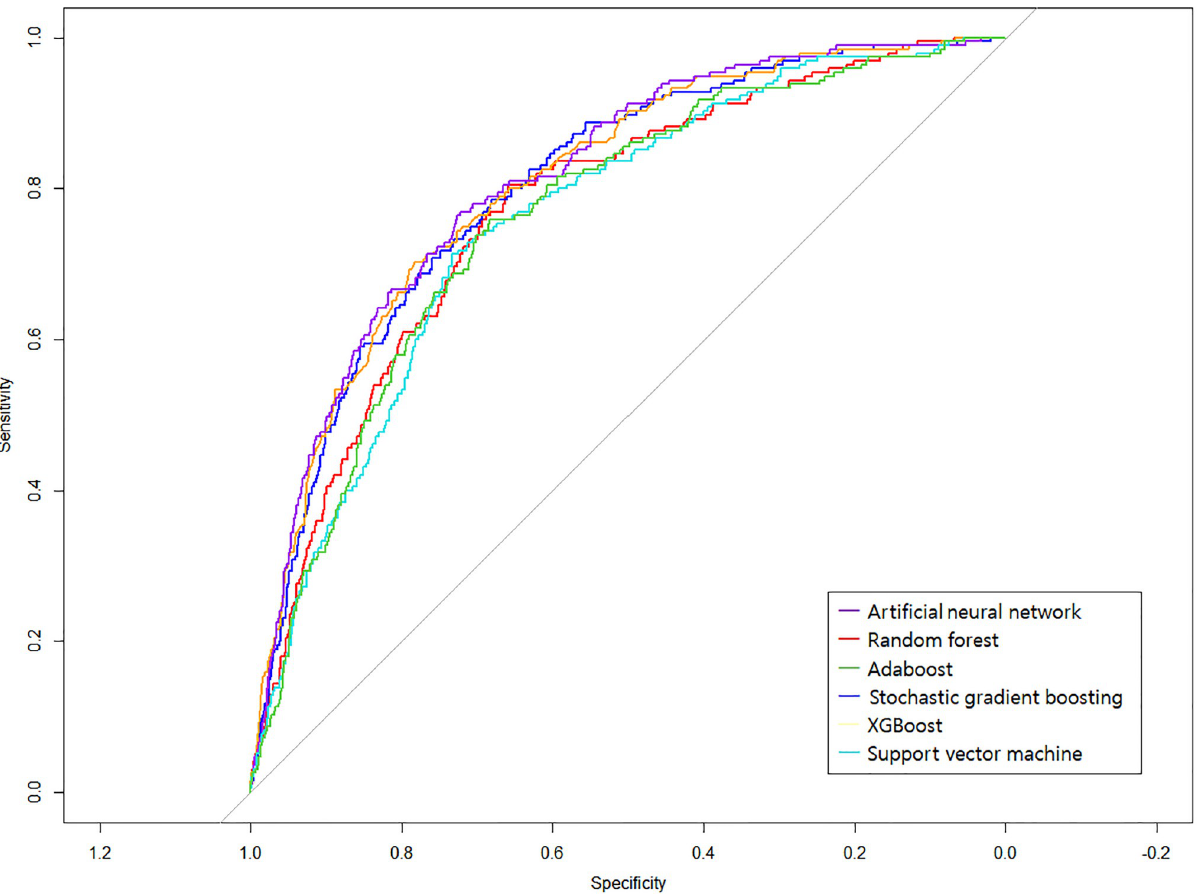
Fig 1. ROC curves for six machine learning models in predicting depression. Ten-fold cross-validation was used to build and evaluate the prediction models. Different colors represent the different machine learning classifiers used in this study. The gray line is the reference corresponding to the performance of a classifier that completely and randomly classifies the condition.